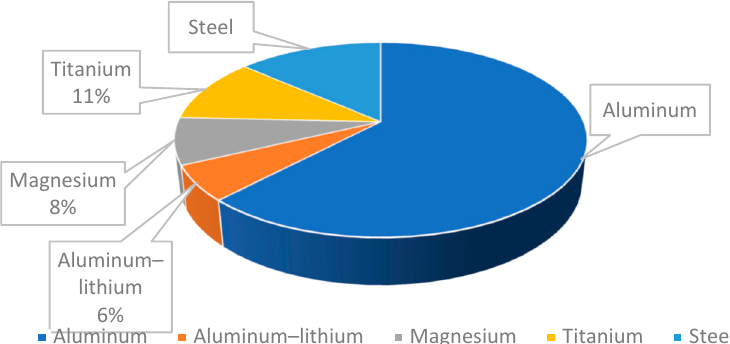
Figure 2. FMLs according to base material.